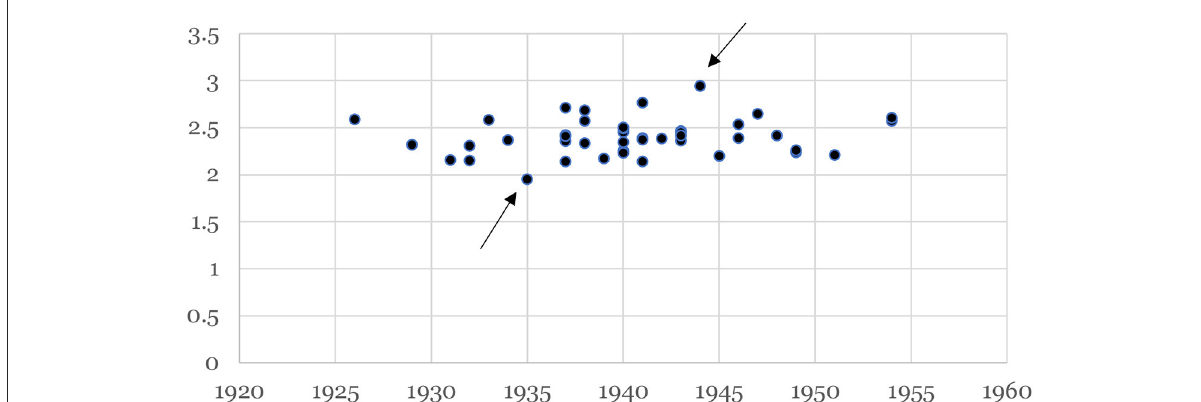
FIGURE5 Plot of the fractal dimension FD across time. The data shows no trend and describes quantitatively the varying complexity of Frida’s work that remained constant, on average, along her professional life. There are extreme values indicated by arrows, one with value 1.9 produced in 1935 and one with FD = 2.9 painted in 1944. These two portraits are shown in Figure 6.